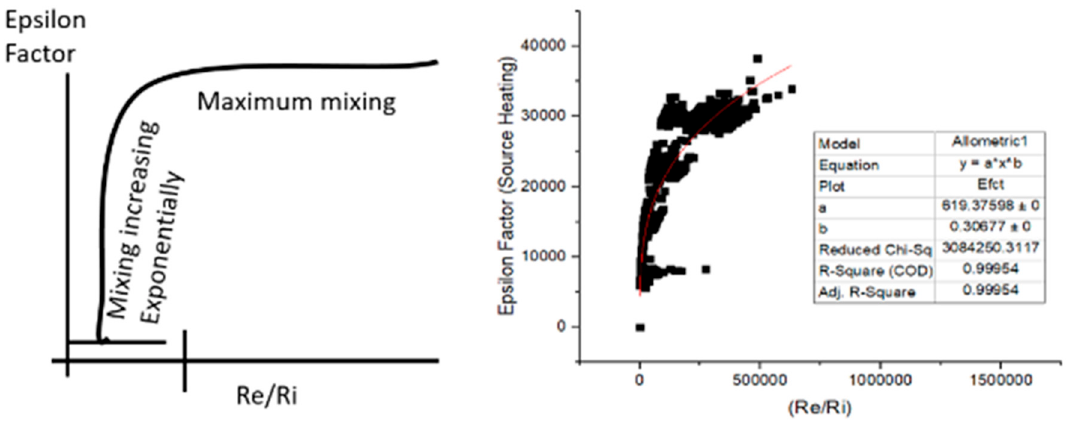
Figure 3. ( left ) The typical trend of ε factor for heating and draw experiments and ( right ) fit for a heating experiment that was carried out between 0.15 and 0.9 GPM.